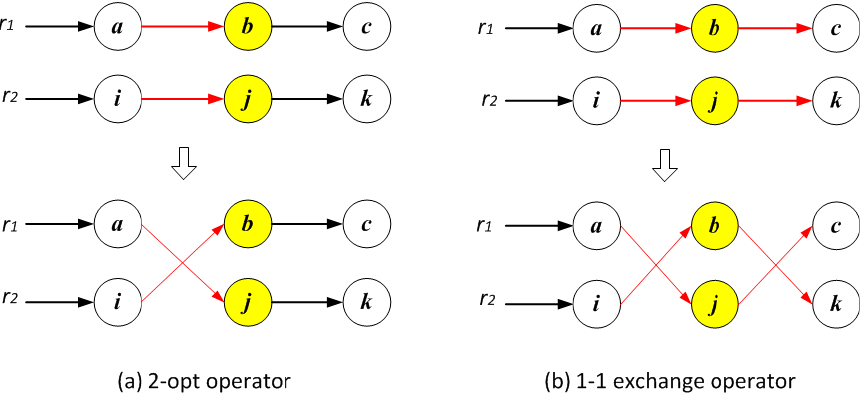
Figure 4. Neighborhood operators.